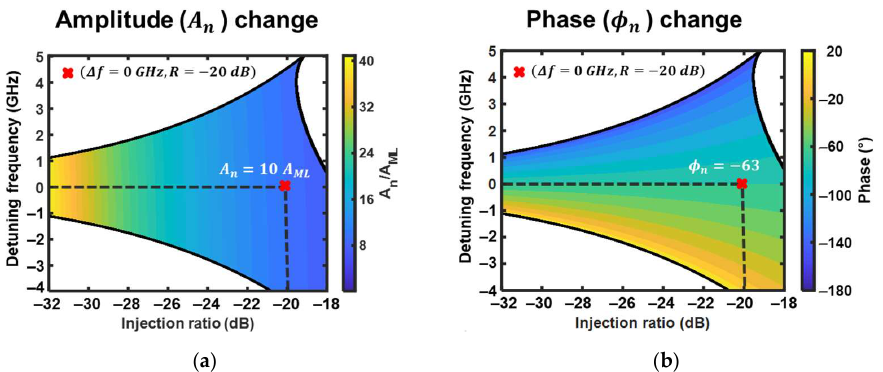
Figure 4. Injection-locking map exhibiting the dependence of the ( a ) amplitude and ( b ) phase of the OIL lasers on the injection-locking parameters.